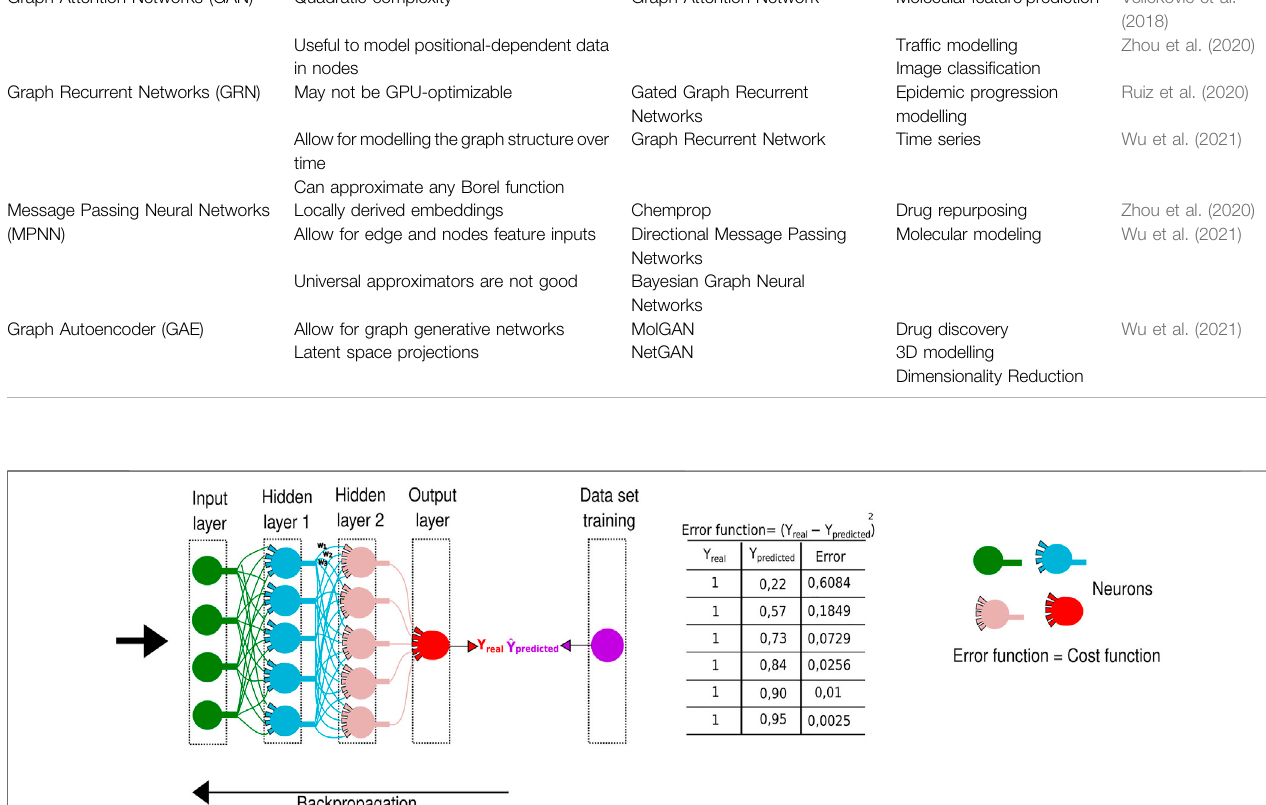
Frontiers in Chemistry |